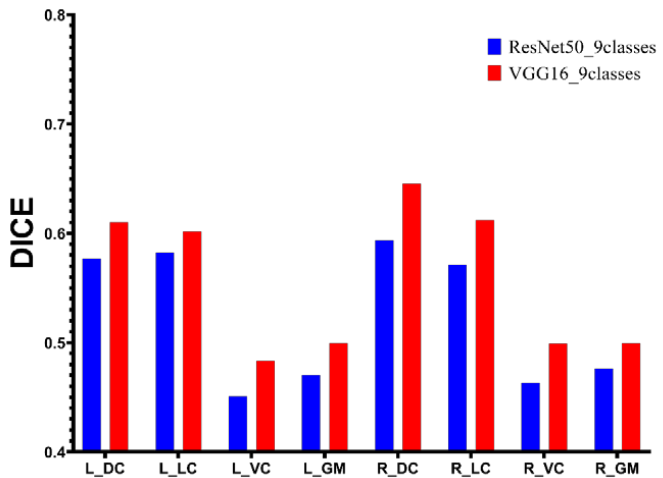
Figure 4. The comparison between different encoders.